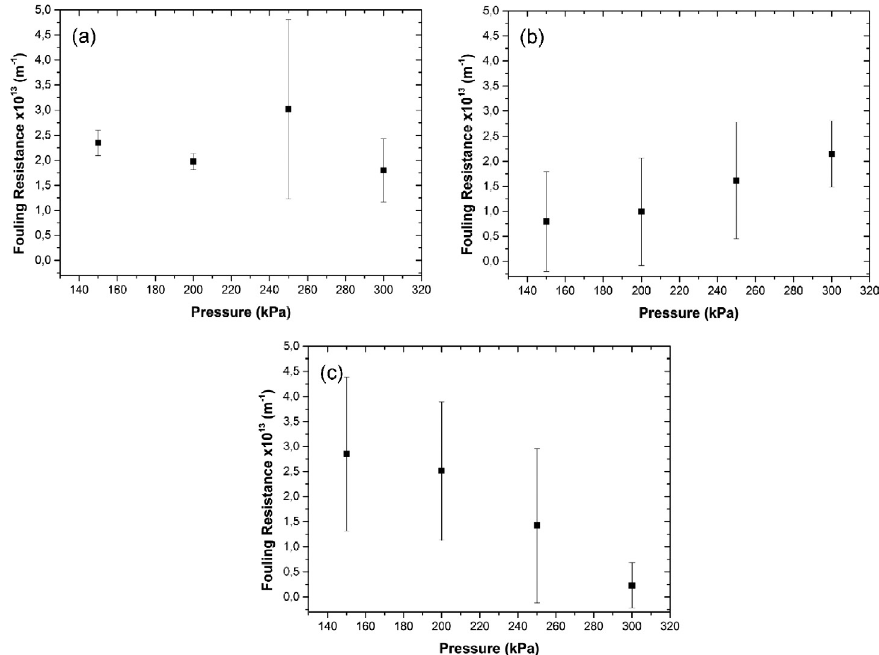
Figure 6. Analysis of fouling resistance of membranes by pressure. (a) Support, (b) PA-1 and (c) PA-2.